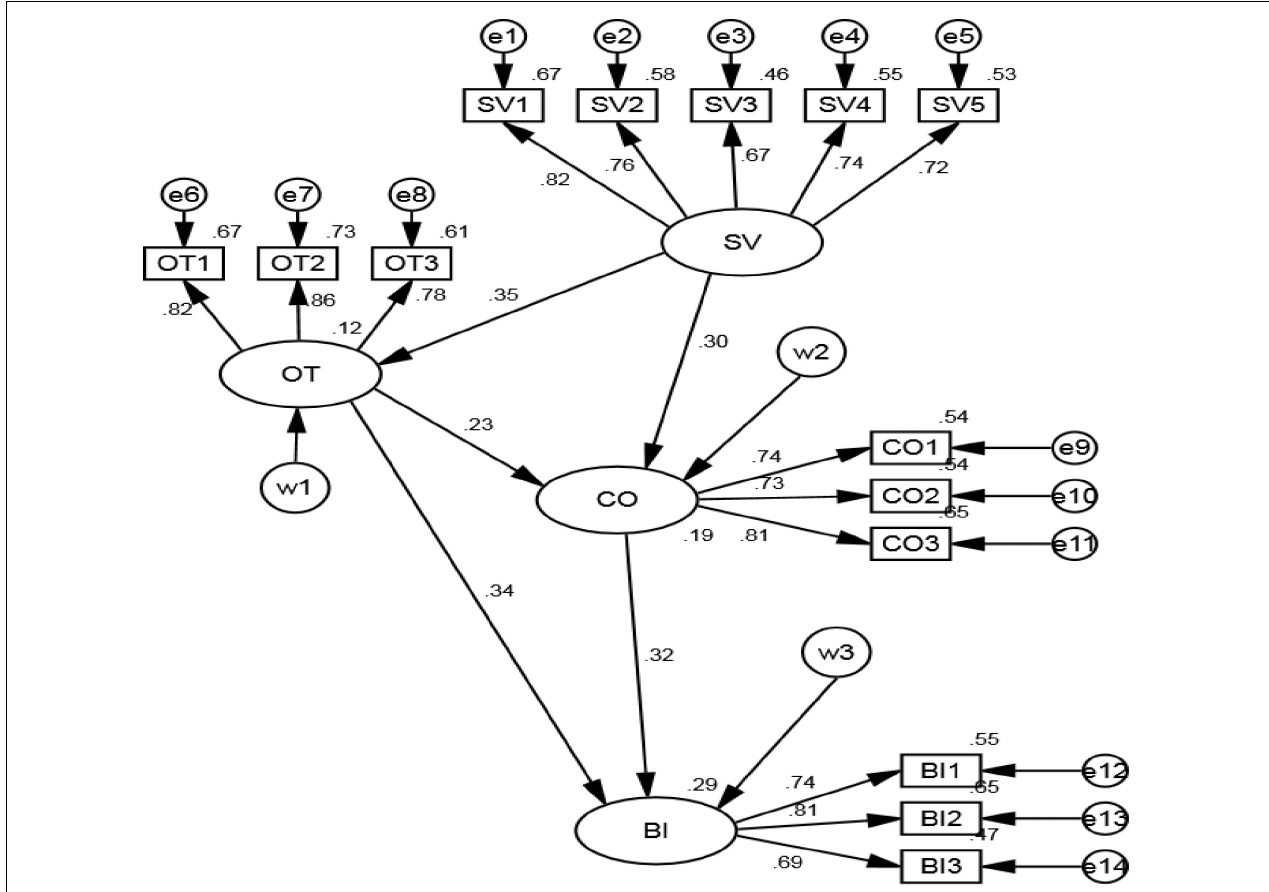
FIGURE 2 | Normalized path results.